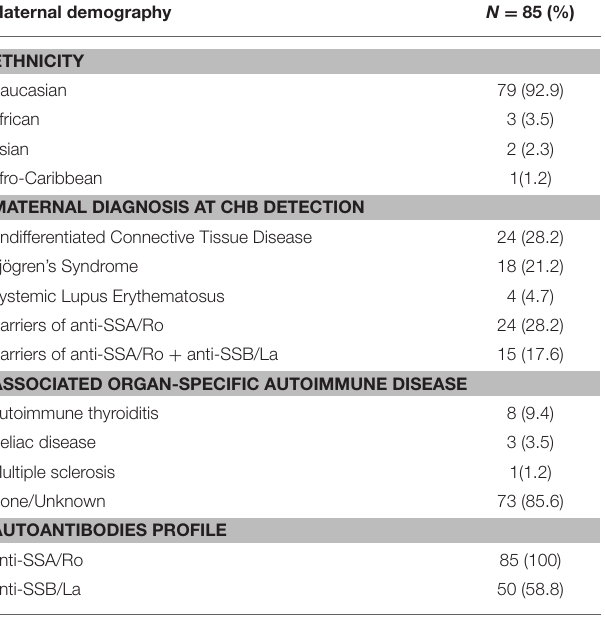
TABLE 2 | Demographic information.